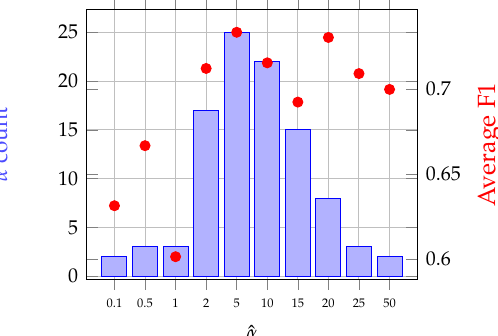
Figure 12. Bar plot of ˆ α values chosen by cross-validation and the average of associated F1 scores (red dots) for the classification of old and young grasslands using α GMK. Nota Bene : The value ˆ α = 0 was never